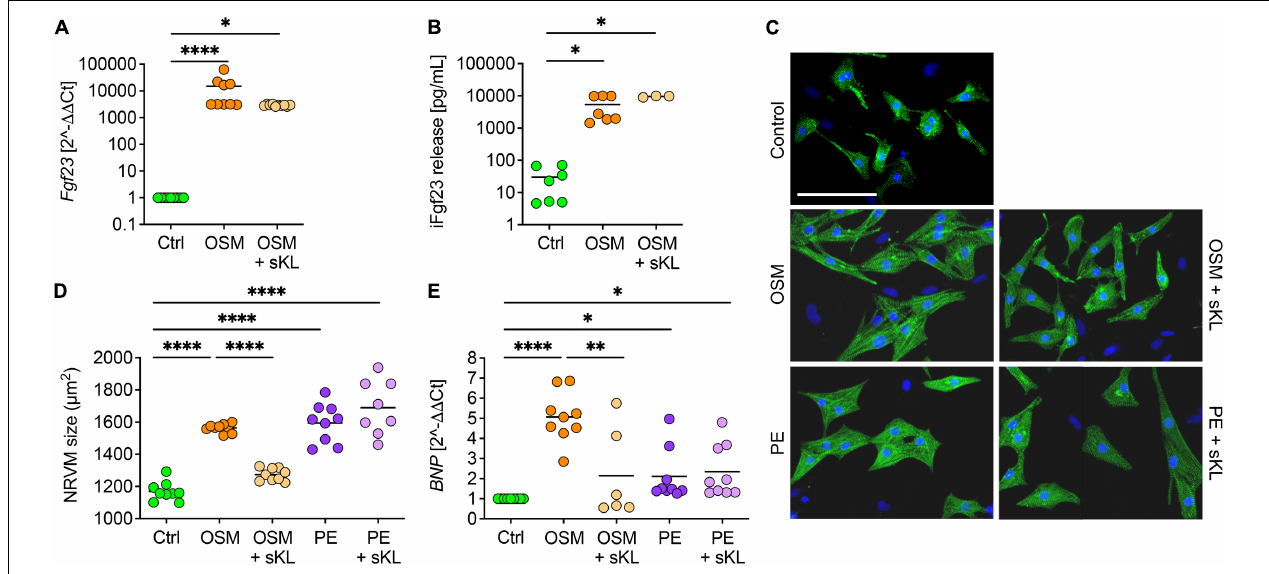
FIGURE 7 | Soluble klotho suppresses cardiac FGF23-induced cardiac hypertrophy in vitro . (A) Stimulation with oncostatin M (OSM) increases endogenous Fgf23 mRNA expression in isolated NRVM irrespective of cotreatment with soluble klotho (sKL). (B) ELISA-based quantification of intact Fgf23 (iFgf23) in conditioned medium of NRVM reveals enhanced iFgf23 release due to OSM treatment, while sKL costimulation does not alter OSM-mediated high iFgf23 secretion. (C,D) Immunofluorescence images of isolated NRVM and quantification of cross-sectional cell area observe hypertrophic growth of OSM stimulated NRVM. Phenylephrine (PE) serves as the positive control for cardiac hypertrophy. Cotreatment with sKL protects from cardiac hypertrophy induced by OSM but not by PE. Myocytes are labeled with anti- α -actinin (green) and nuclei are counterstained with DAPI (blue) (original magnification × 20; scale bar 100 µ m). (E) Quantitative real-time PCR analysis shows increased expression of BNP in OSM and PE-treated NRVM compared to Ctrl that is only blocked by sKL in the OSM group. Data are given as scatter dot plots with means; ∗ p < 0.05, ∗∗ p < 0.01, and ∗∗∗∗ p < 0.0001 analyzed using one-way ANOVA or Kruskal–Wallis test followed by Sidak’s or Dunn’s multiple comparisons post hoc tests, respectively, according to Shapiro–Wilk normality test; n = 6–9 independent isolations of NRVM; conditioned medium was used from n = 3–7 independent NRVM isolations.